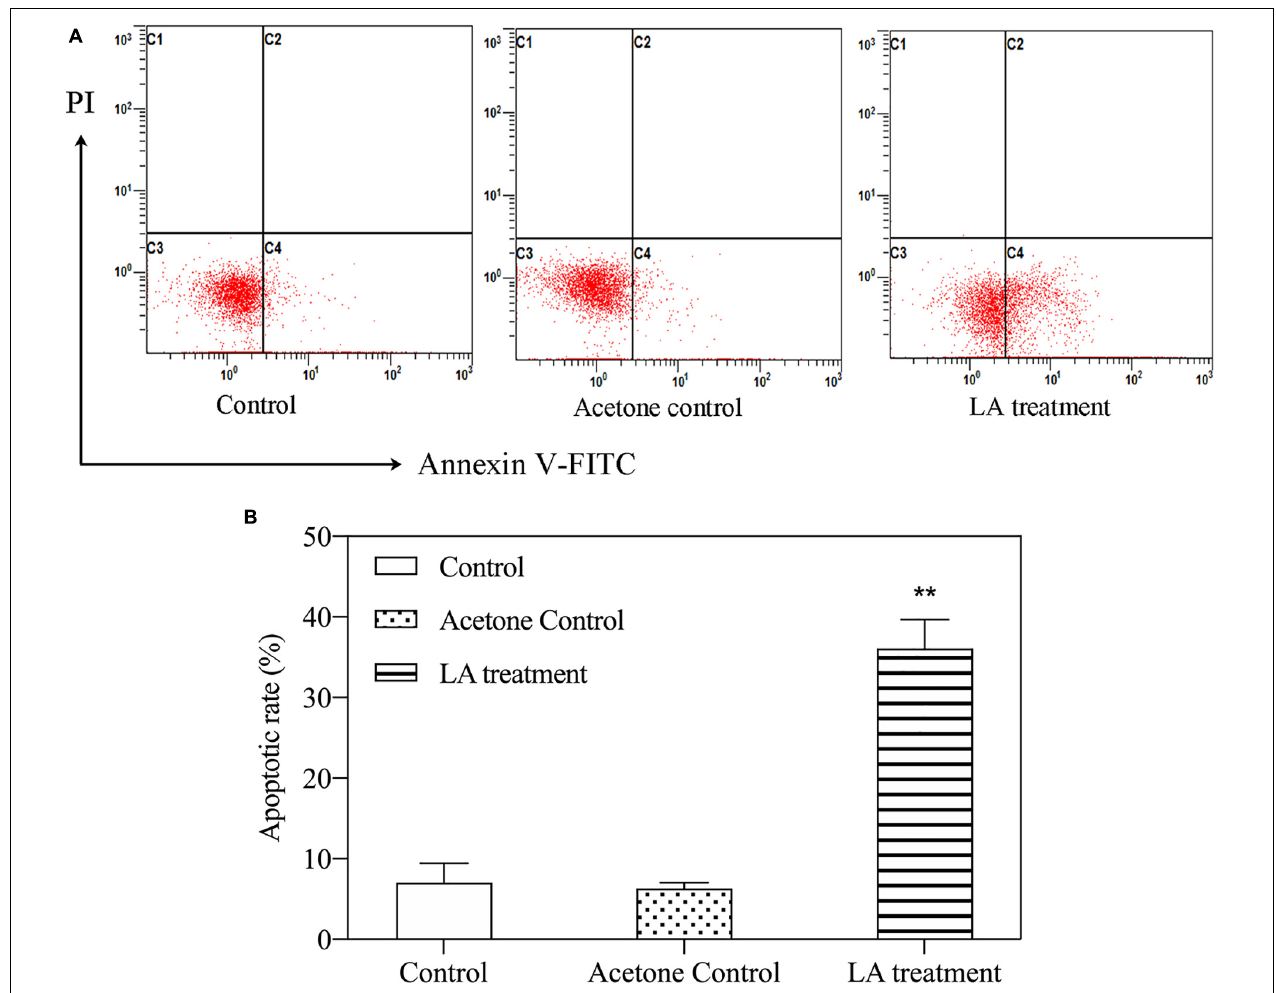
FIGURE 5 | Apoptosis of H. akashiwo cells treated with LA. (A) Representative flow-cytometric analysis of apoptosis. (B) Percentages of apoptotic cells by flow cytometry. The data are presented as the mean SD ( n = 3). Asterisks indicate significant differences from acetone control ( ∗∗ indicate p <